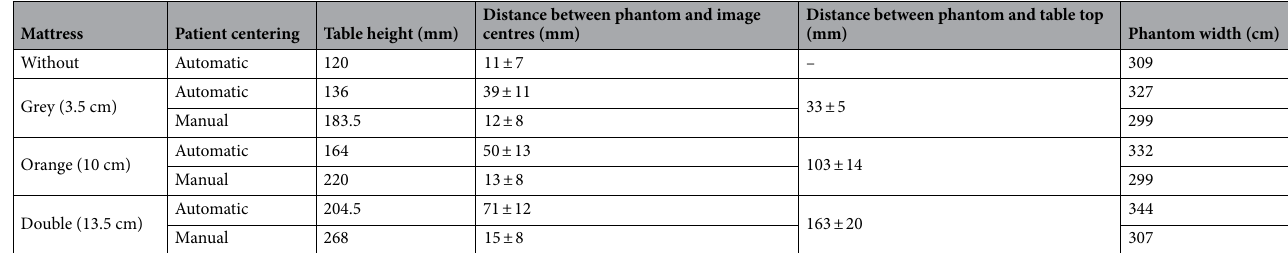
Table 1. Table height, distance between the phantom and image centres, distance between the phantom and the table top and phantom width obtained for acquisitions of phantom with and without an additional mattress.